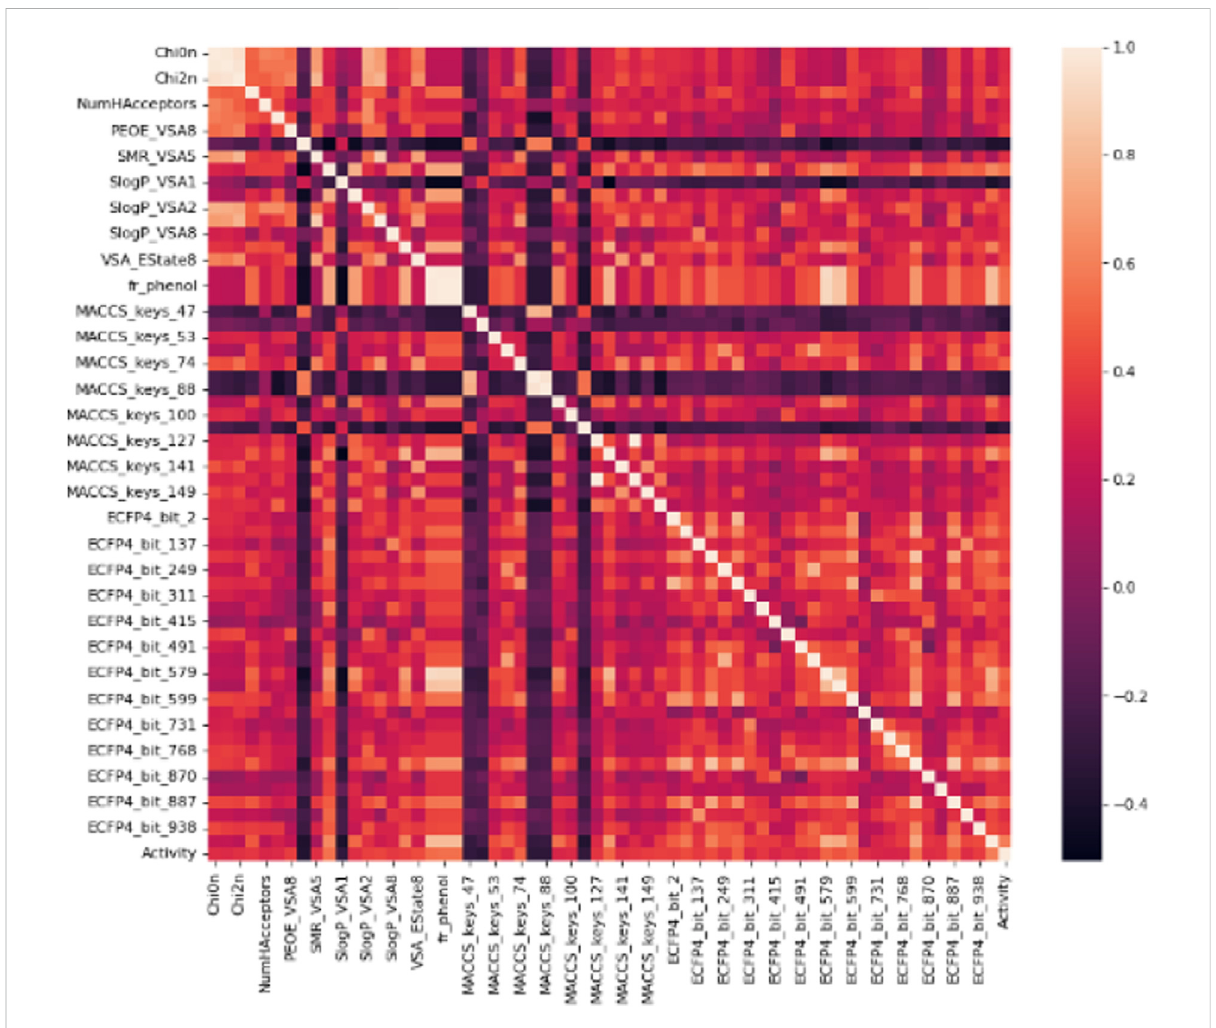
FIGURE 1 A correlation histogram of selected descriptors against the inhibitory activity. The scale represents the value of the Pearson correlation coef fi